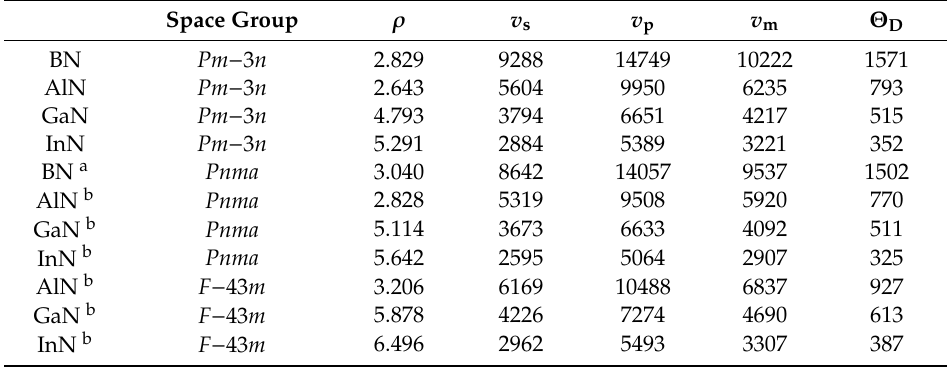
Table 2. The v s , v p , v m (m / s), and Θ D (K) of XN in the Pm − 3 n , Pnma and F − 43 m